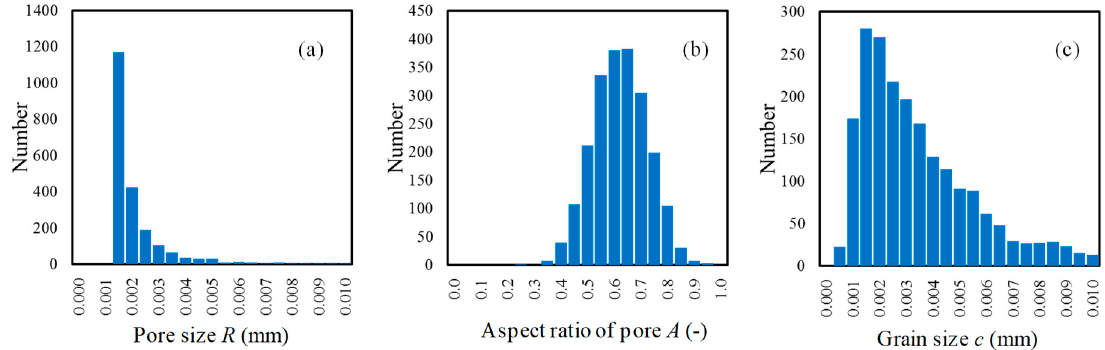
Figure 4. Histogram of the microstructure data of the elements obtained for an arbitrary specimen of the four-point bending test (length 40 mm) as shown in Figure 3c. The distribution of the microstructure is defined as given in Table 2: ( a ) pore size R ; ( b ) aspect ratio A ; and ( c ) grain size c (initial crack length).